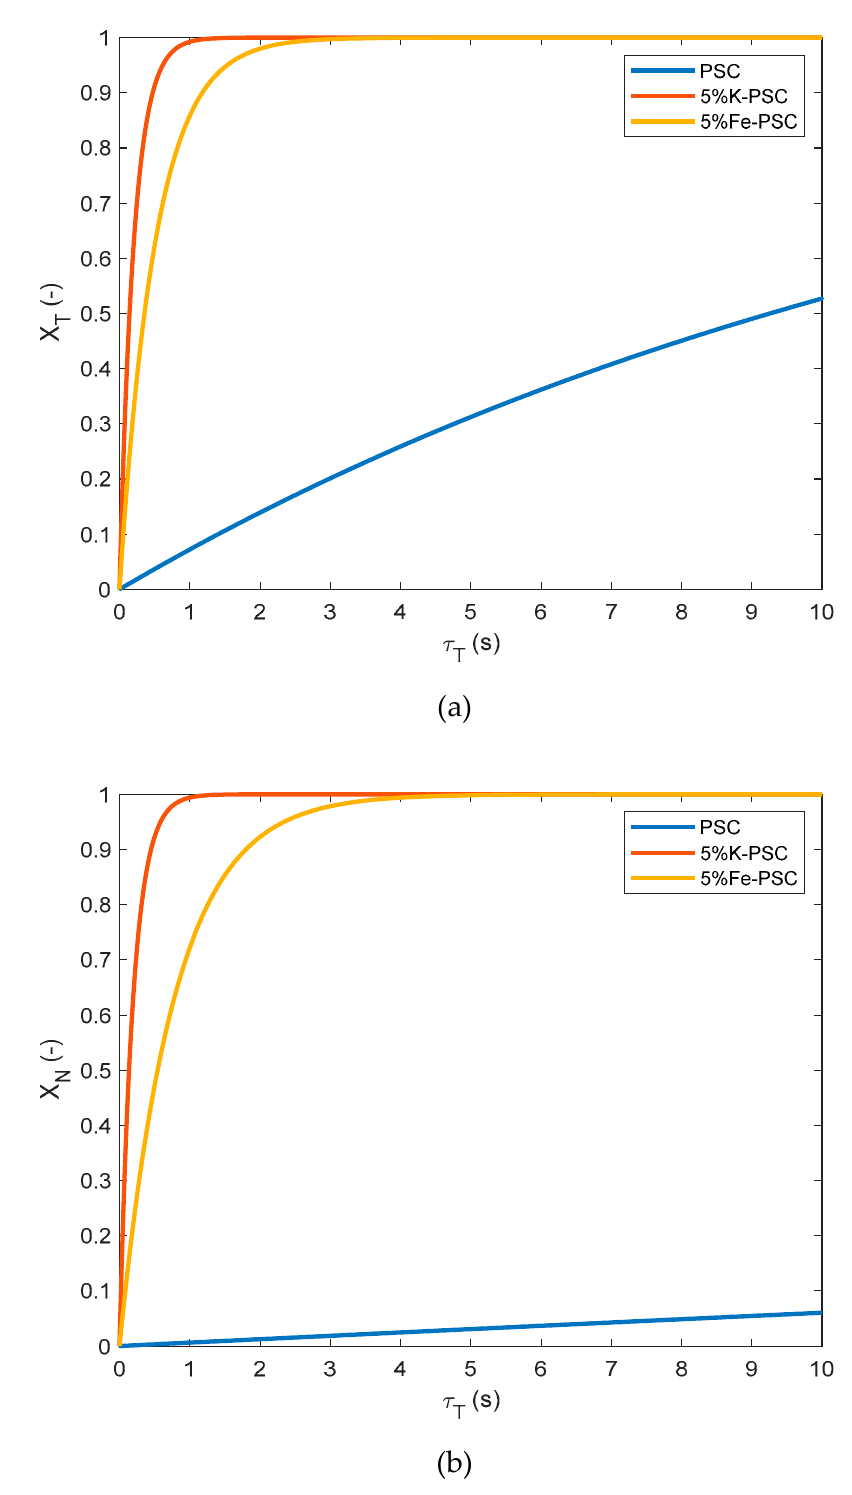
Figure 13. ( a ) Toluene; and ( b ) naphthalene conversion as a function of theoretical residence time at 750 °C for PSC, 5%K-PSC, and 5%Fe-PSC.